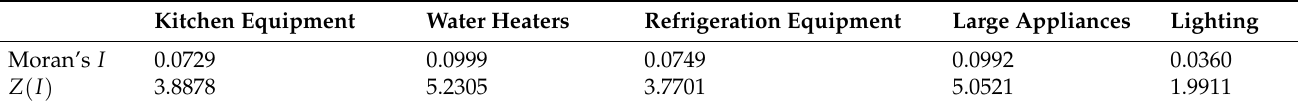
Table 6. LISA clustering data of per capita carbon emissions by equipment type.